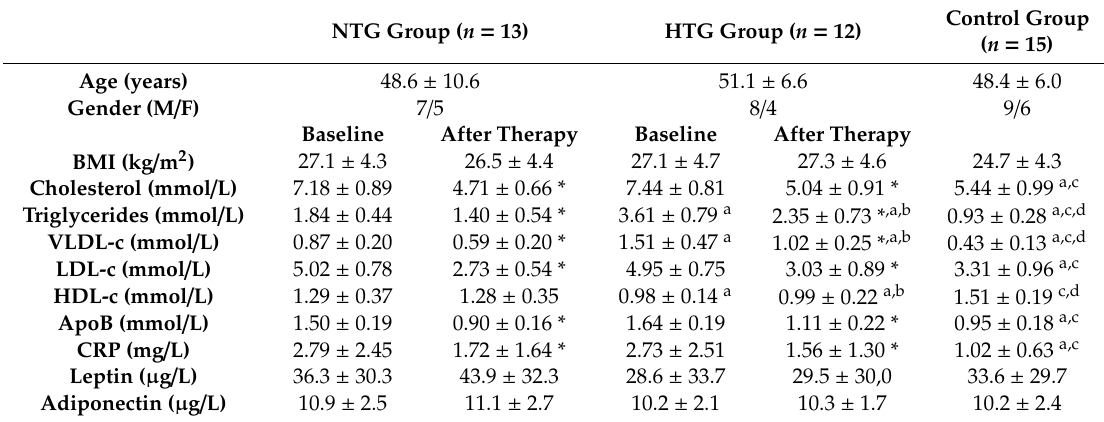
Table 1. Anthropometric and clinical characteristics, lipid profile, and inflammatory